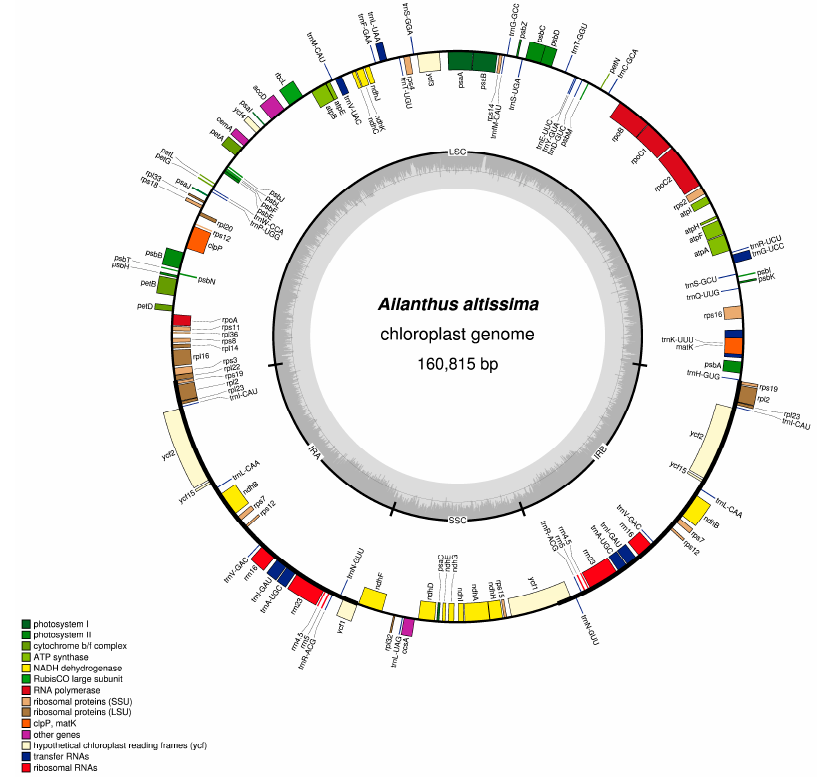
Figure 1. Circular gene map of A. altissima complete chloroplast genome. Genes drawn on the outside of the circle are transcribed clockwise, whereas those inside are transcribed clockwise. The light gray in the inner circle corresponds to AT content, while the darker gray corresponds to the GC content. Large single copy (LSC), Inverted repeats (IRa and IRb), and Small single copy (SSC) are indicated. The tree of heaven ( A. altissima ) chloroplast genome harbored a total of 113 different genes, comprising 79 protein coding genes (PCGS), 30 transfer RNA (tRNA) genes, and four ribosomal RNA (rRNA) genes (Table 1). All the 77 PCGS started with the common initiation codon (ATG), but rps19 and ndhD genes started with alternative codons GTG and ACG respectively, this unusual initiator codons have been observed to be common in other angiosperm chloroplast genomes [32–34]. Of the 79 protein coding sequences, 60 are located in the LSC, 11 in the SSC and eight genes were duplicated